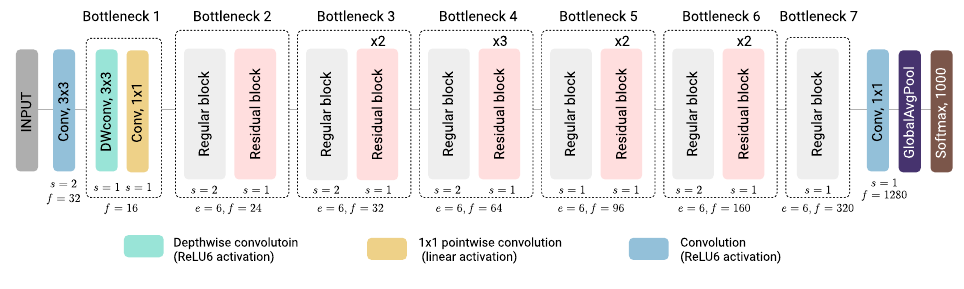
Figure 14. MobileNetV2